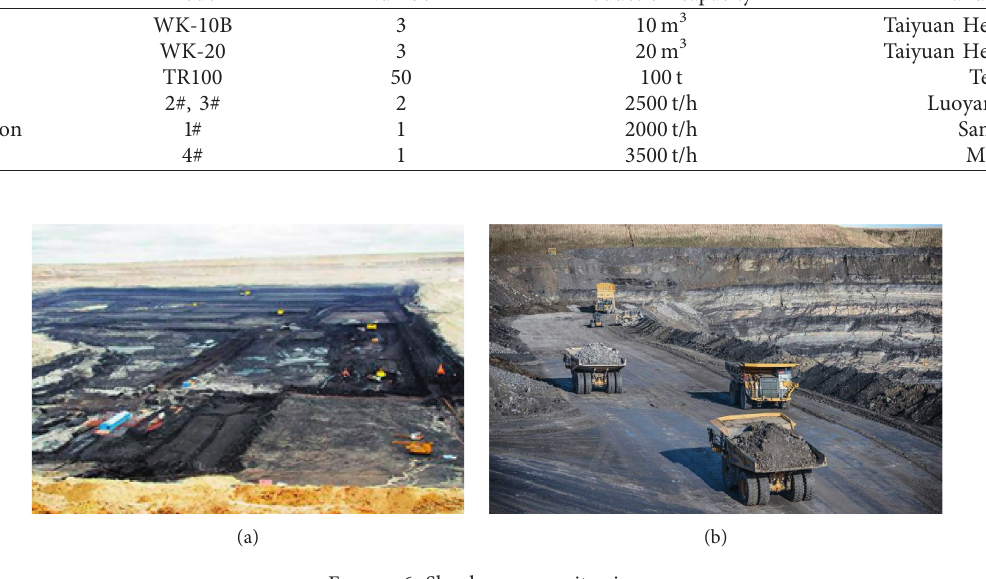
Figure 6: Shenbao open-pit mine.